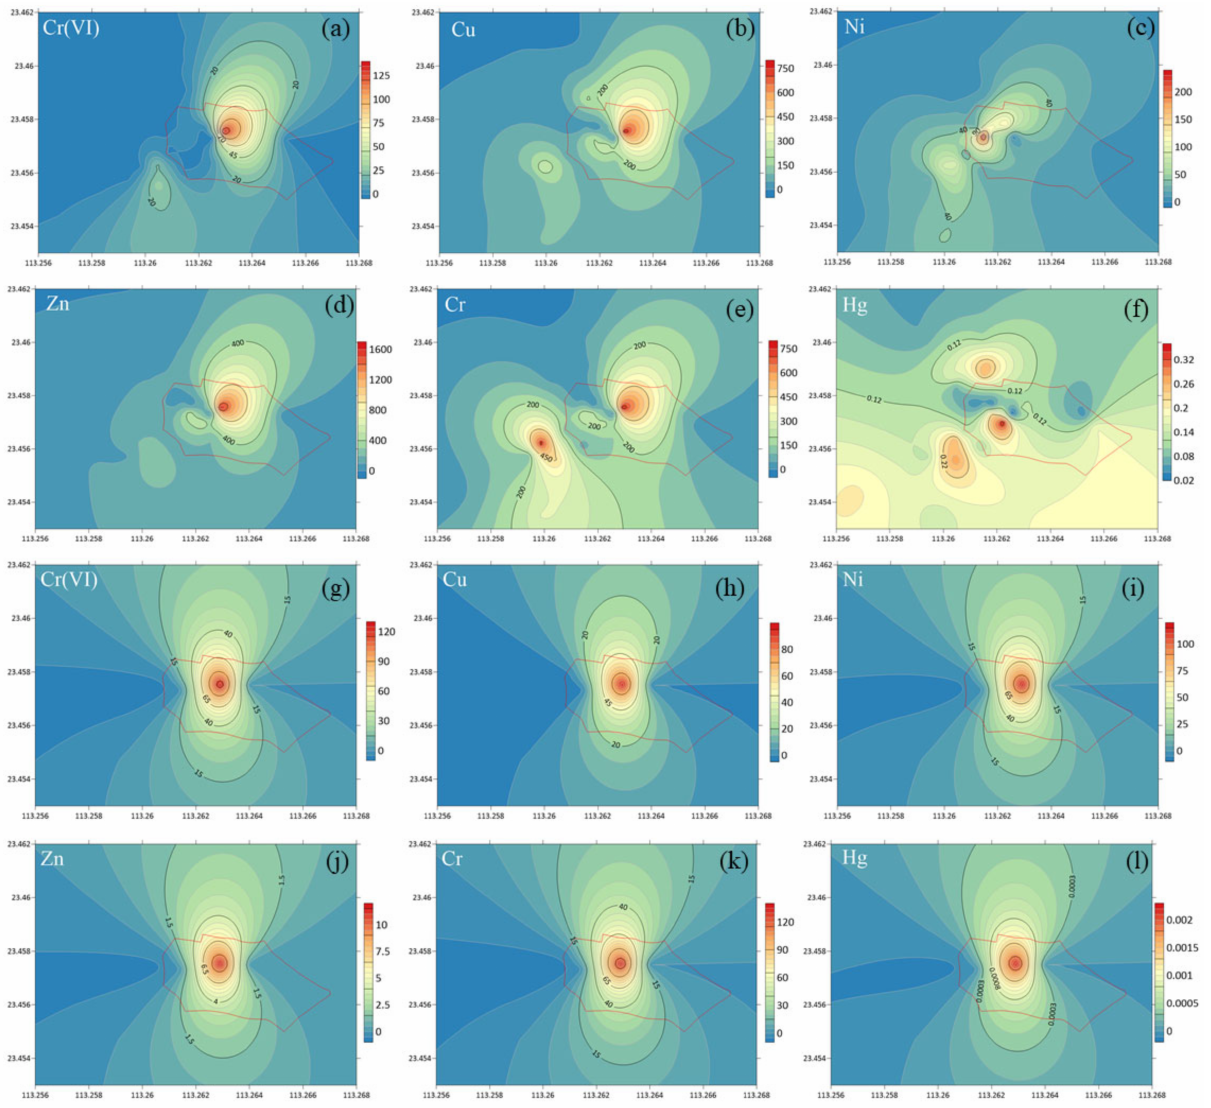
Figure 2. Distribution of heavy metals in surface soil (0–20 cm) of Factory A and its surrounding area. ( a – f ) are the contour plots of the heavy metal concentration (mg/kg) in soil. ( g – l ) are the contour plots of the heavy metal concentration (mg/L) in